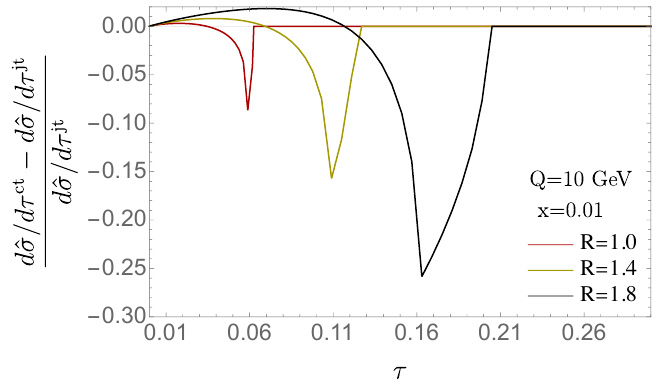
Figure 3 . Relative difference between τ ct and τ jt distributions with three values of R = 1 . 0 , 1 . 4 , 1 . 8 at x = 0 . 01 and Q = 10